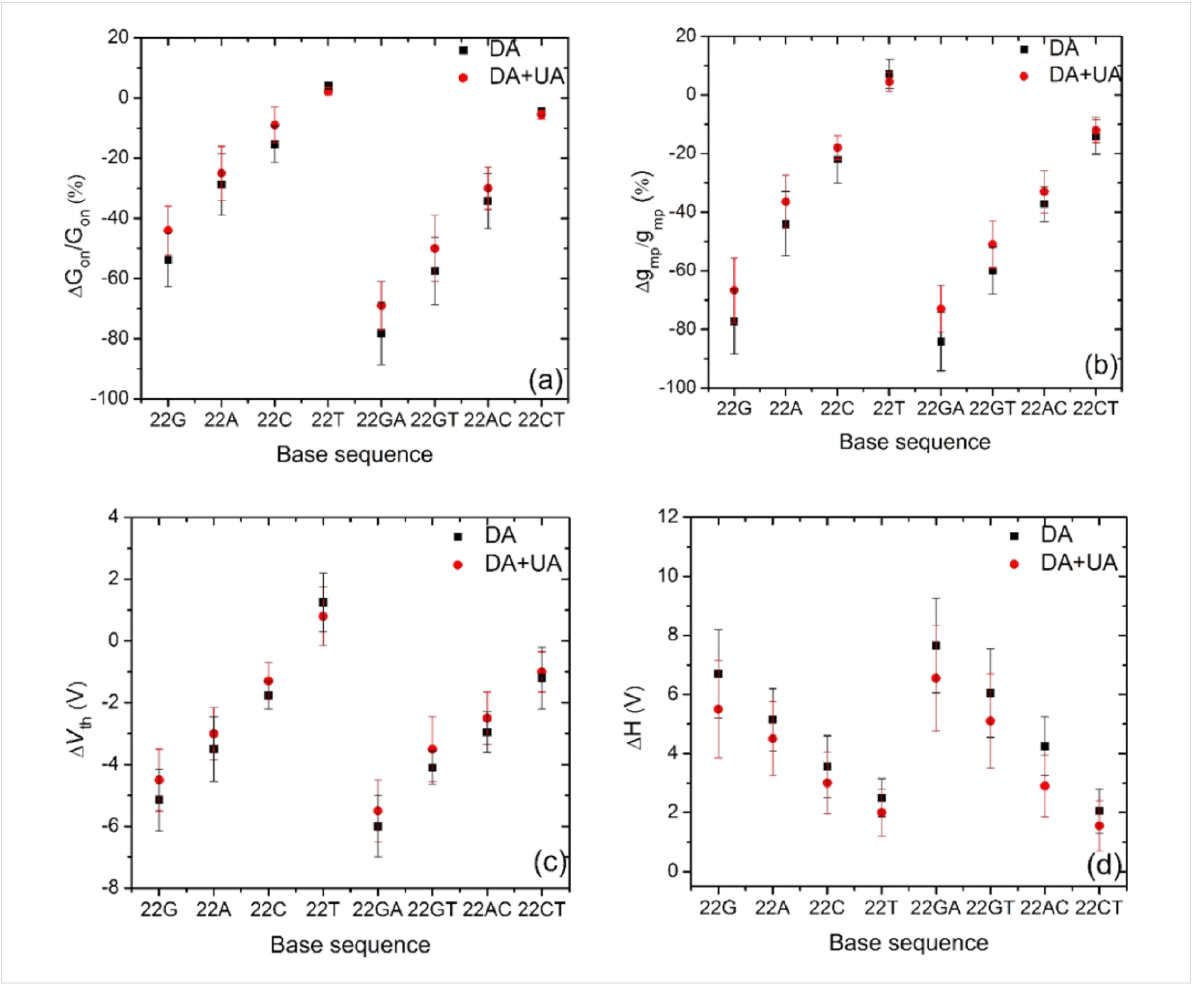
Figure 4: Summary of the sequence-dependent variation in transistor electrical parameters induced by the DA and DA–UA solution mixtures. (a) ∆ G on / G on , (b) ∆ g mp / g mp , (c) ∆ V th , and (d) ∆ H . The “ − “ sign on the y -axis in (a) and (b) indicates the decrease in the respective parameters with respect to the ssDNA-functionalized state. The “ − “ and “+” on the y -axis in (c) and (d) indicate the left shift in V th and increase in H , respectively, with respect to the ssDNA functionalized